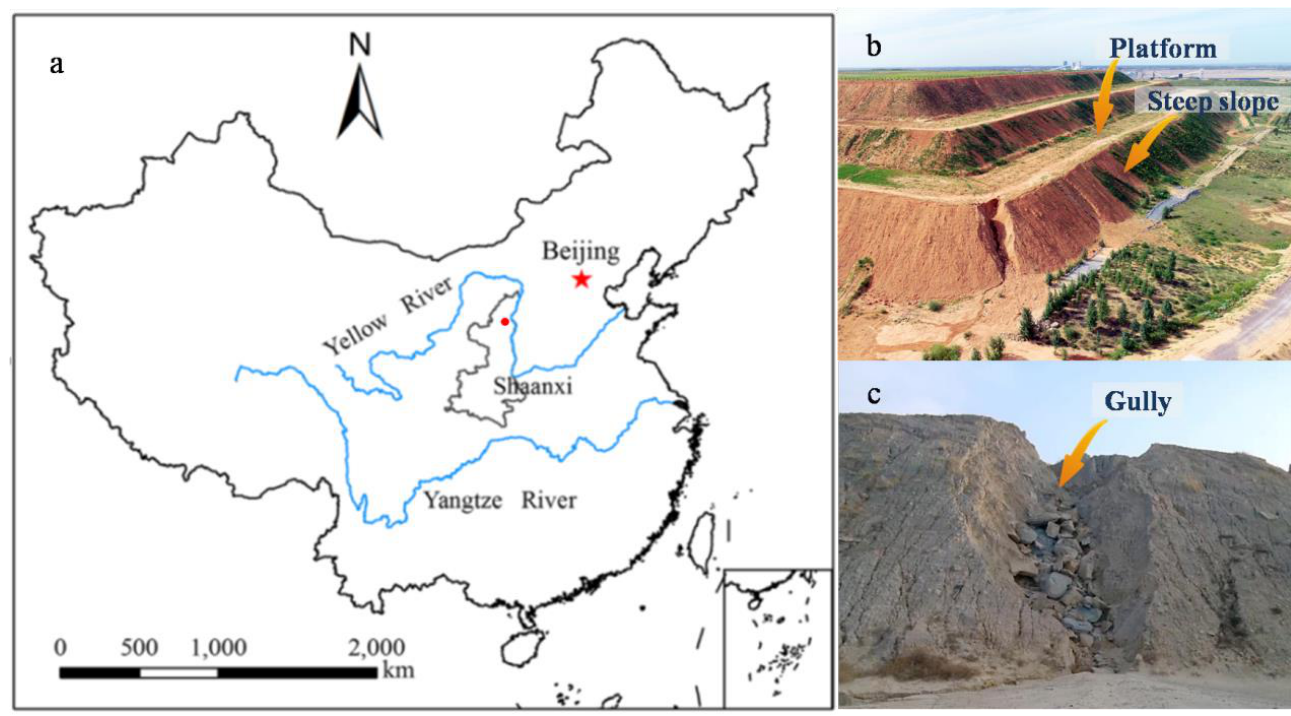
Figure 1. ( a ) Locations of the experimental soils; ( b ) The platform-slope system of spoil dump; ( c ) The gully developed on platform-slope system.